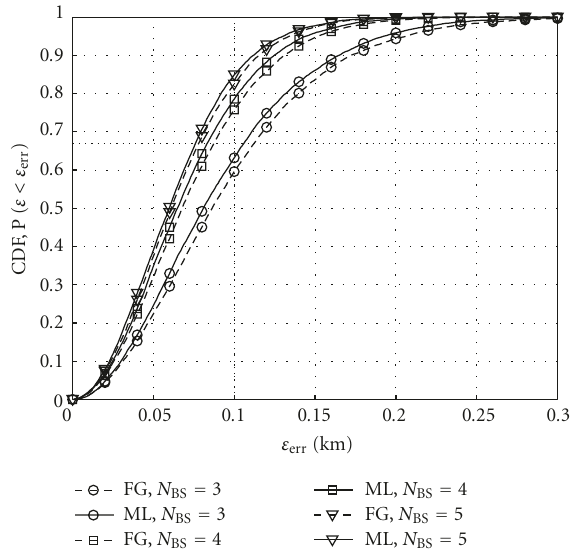
Figure 13: CDF for di ff erent numbers of BSs, R = 3 km, σ n = 0 . 1